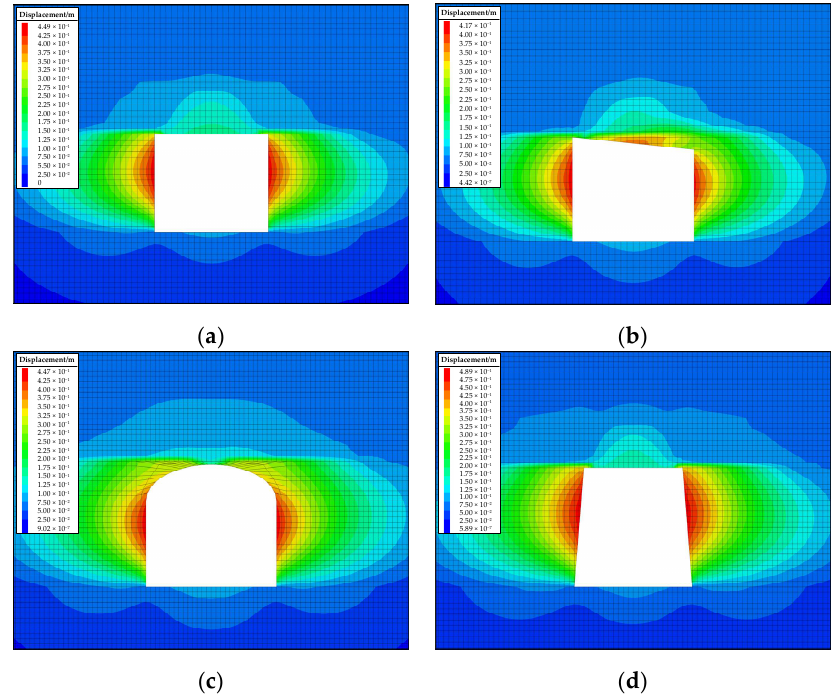
Figure 12. Characteristics of displacement field distribution of surrounding rock in different channel section forms: ( a ) rectangle; ( b ) slanted-top rectangle; ( c ) straight-walled circular arch; ( d ) trapezoid.